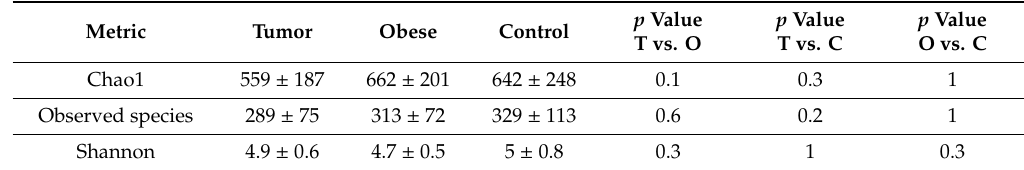
Table 2. Alpha diversity. Bacterial diversity values are given as mean ± standard deviation at a rarefaction depth of 10,000 sequences per sample. Alpha diversity was compared between pairwise comparisons by means of a non-parametric t-test using the compare_alpha_diversity.py script of QIIME. None significant variation was observed. Abbreviations: T = tumor; O = obese; C = Control.